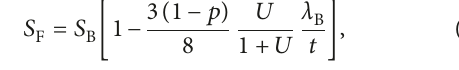
2 Te 3 films of varying